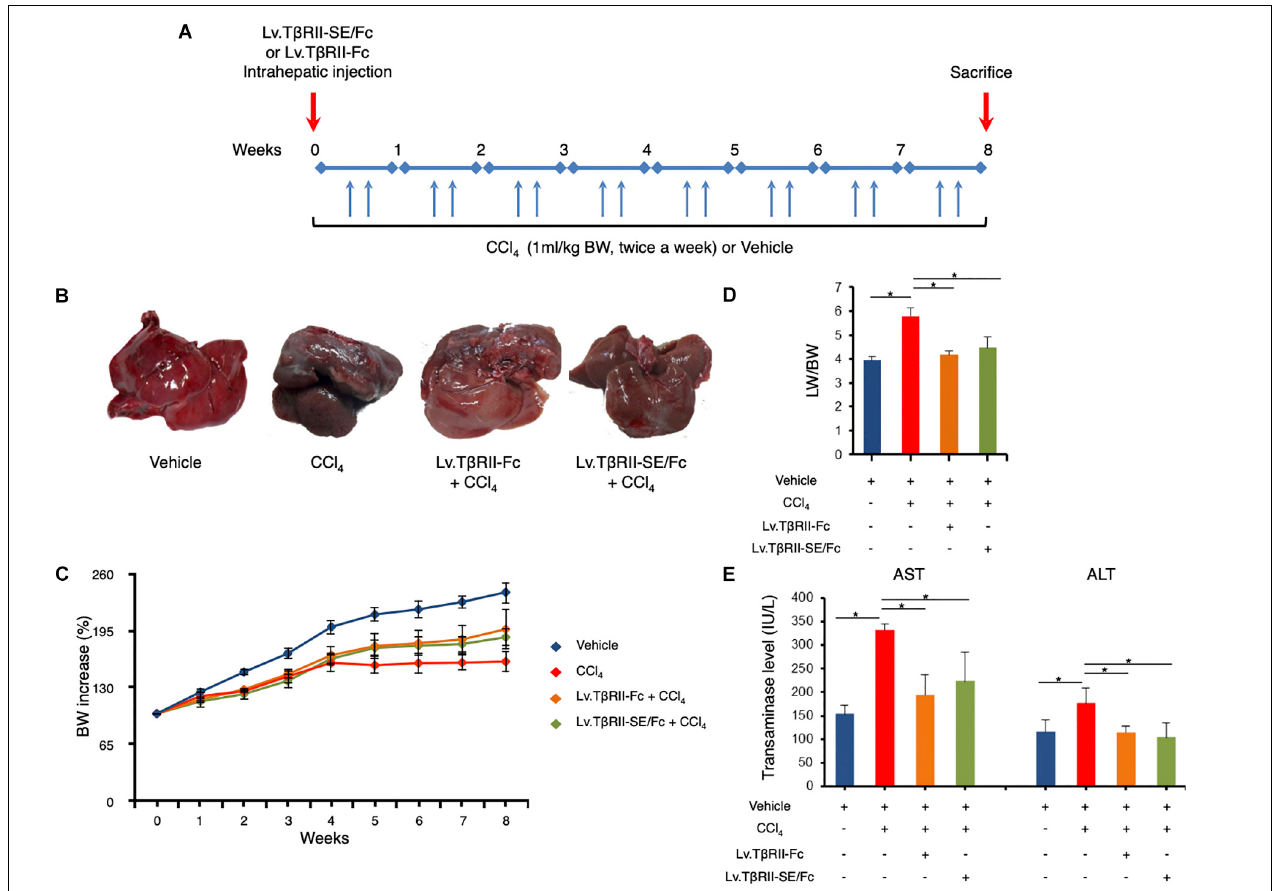
FIGURE 5 | T β RII-SE/Fc overexpression prevents CCl 4 -induced liver damage development. (A) Experimental design including lentiviral vector and CCl 4 administrations. Animals were euthanized by CO 2 inhalation after 72 h of the last CCl 4 injection. (B) Representative images of liver gross appearance corresponding to rats treated with vehicle, CCl 4 , Lv.T β RII-Fc + CCl 4 , and Lv.T β RII-SE/Fc + CCl 4 . (C) Percentage (%) of both body weight gain (left panel) and (D) liver-to-body weight ratio (LW/BW) (right panel) of animals in the different experimental groups. * p < 0.05, Vehicle vs. CCl 4 , or CCl 4 vs. Lv.T β RII-SE/Fc + CCl 4 . (E) Serum